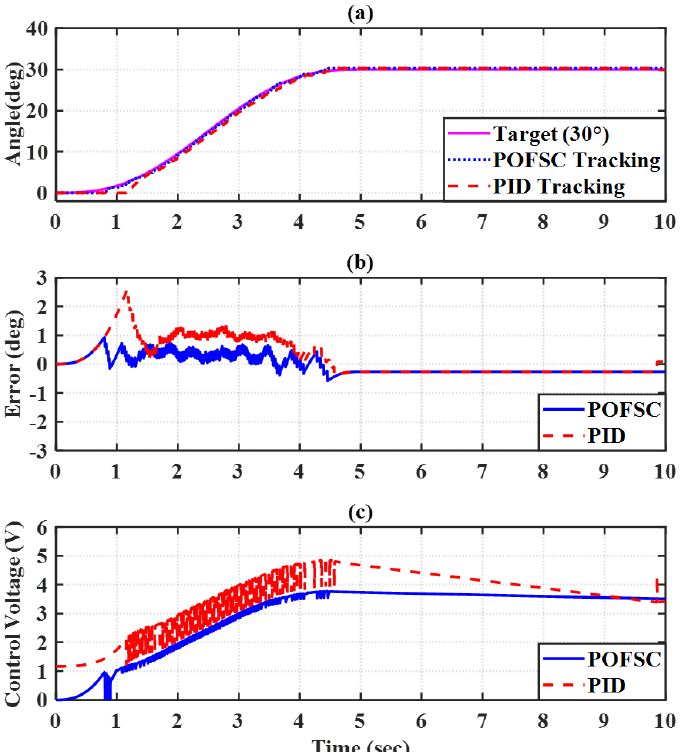
Figure 15. Comparison of fifth-order path-tracking between the POFSC and PID for the shoulder joint flexion angle of 30°. ( a ) System response, ( b ) tracking error, and ( c ) control voltage.